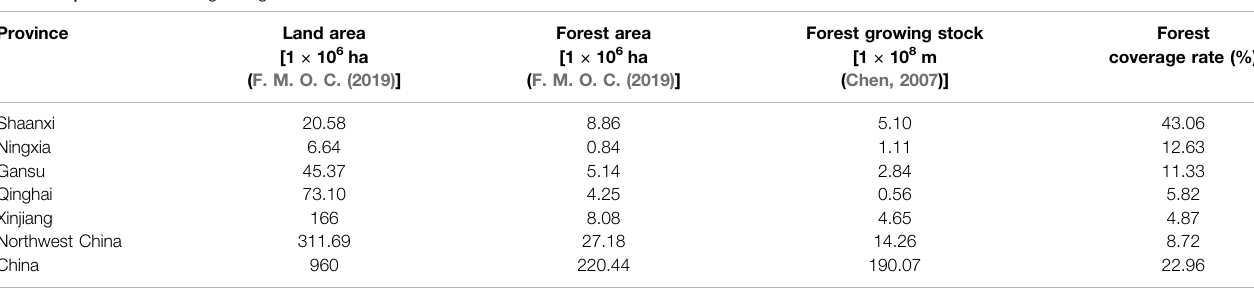
TABLE 1 | Forest area and growing stock in Northwest China.